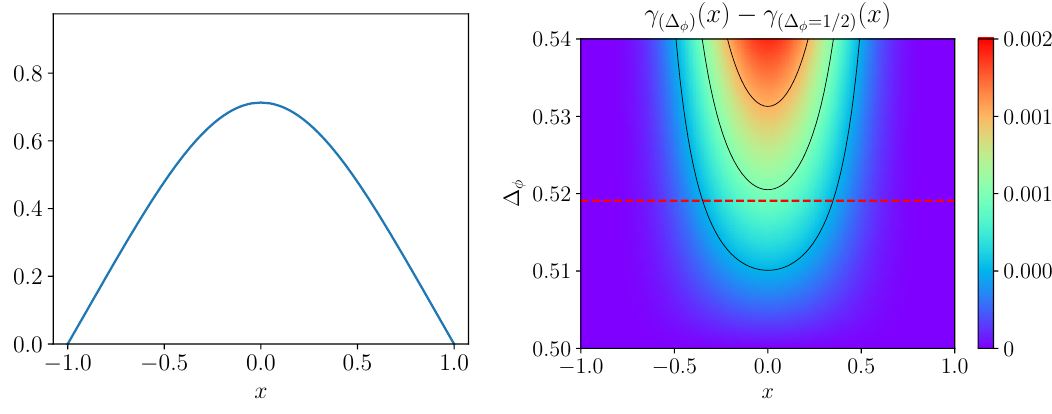
Figure 1 . Solutions of the Yamabe problem in the three-dimensional slab domain ( − 1 < x = x 1 < 1 ). Left: integer Yamabe. Right: solutions of the Fractional Yamabe Equation as ∆ in the range [0 . 5 , 0 . 54] . The plot actually shows deviations from the ∆ solution (in the left pane). The red dashed line is the Conformal Bootstrap value ∆ CB universality class